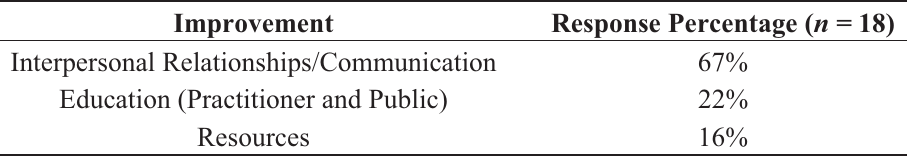
Table 5. Top Three Improvements Suggested for Zoonotic Disease Detection and